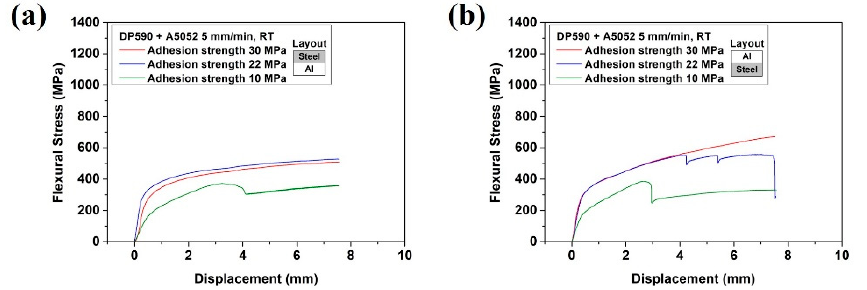
Figure 11. DP590–A5052 multi-materials with different adhesion strengths: ( a ) steel (upper)– aluminum (lower) and ( b ) steel (lower)–aluminum (upper).